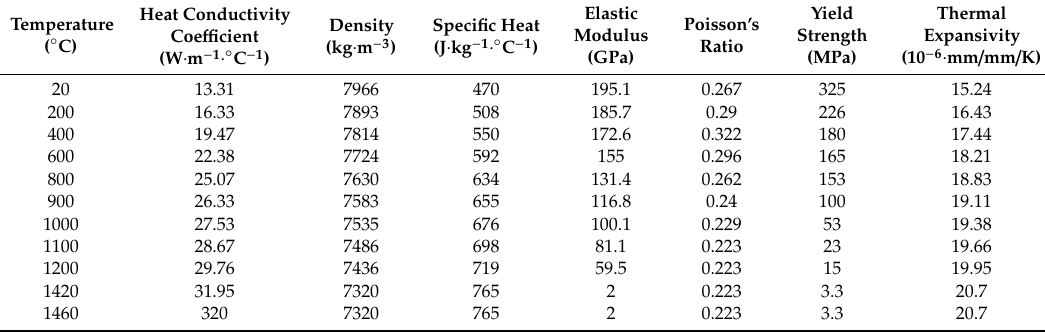
Table 5. Mechanical properties of E316L reproduced from [20], with permission from welding technology, 2019.